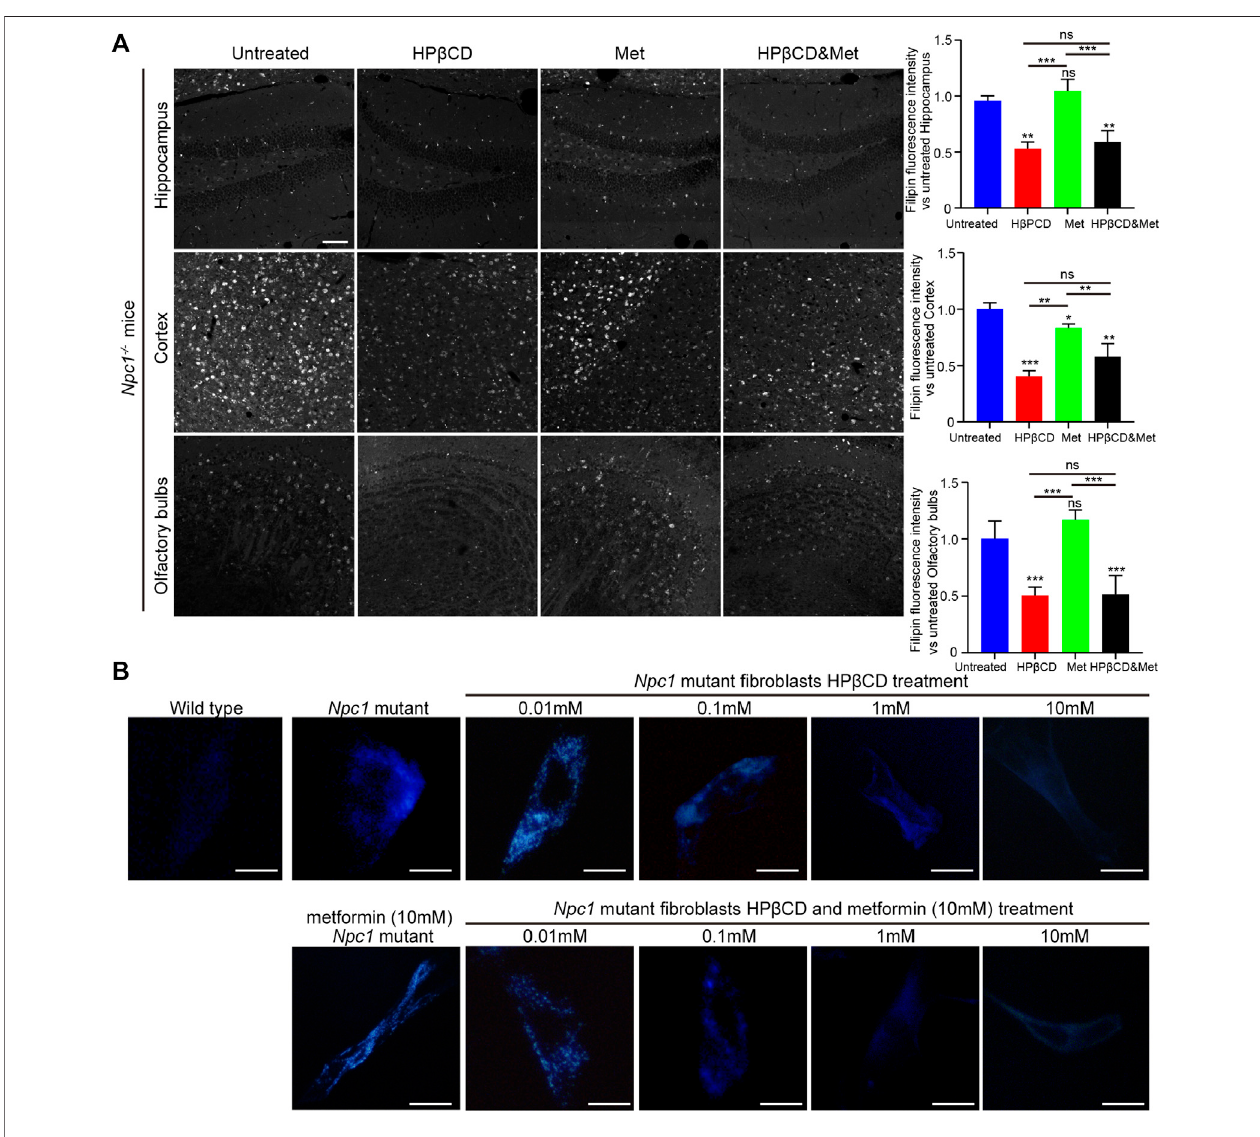
FIGURE6| Effectoftestdrugsoncholesterolaccumulationof Npc1 − / − mice.Filipinstaininginthehippocampus,cerebralcortexandolfactorybulbintheindicated groups (A) , left) (n (cid:1) 4) (scale bar: 100 μ m). Quantitative analysis of fi lipin fl uorescence intensity using Image J (A) , right). Filipin-stained normal and Npc1 − / − mice fi broblastsafter24 htreatmentwithHP β CDor/andmetforminatvariousconcentrations (B) (scalebar:20 μ m).Statisticalanalysisisbasedonone-wayANOVAfollowed by Tukey test, ns represents not signi fi cant, * p < 0.05, ** p < 0.01,*** p < 0.001. All data are provided as means ± SEM.